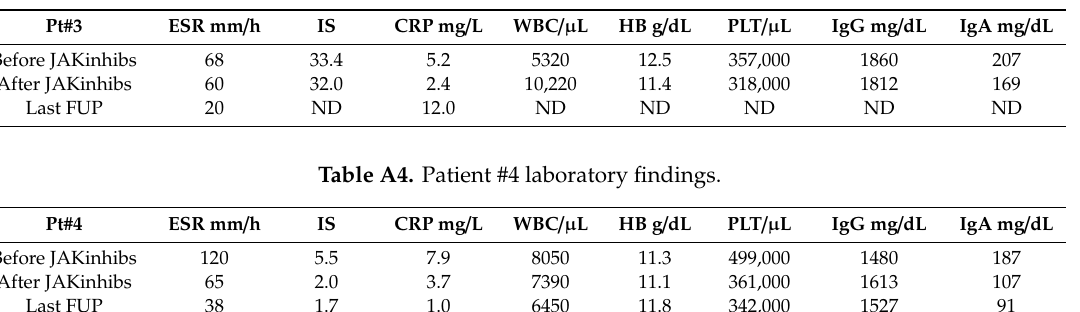
Table A3. Patient #3 laboratory findings.